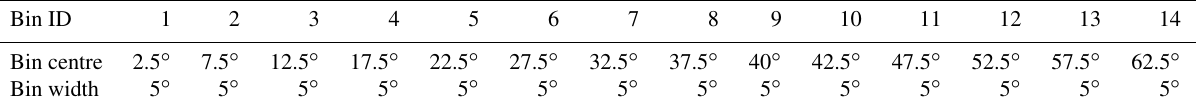
Table 3. Selected incident angle bins. Bin ID